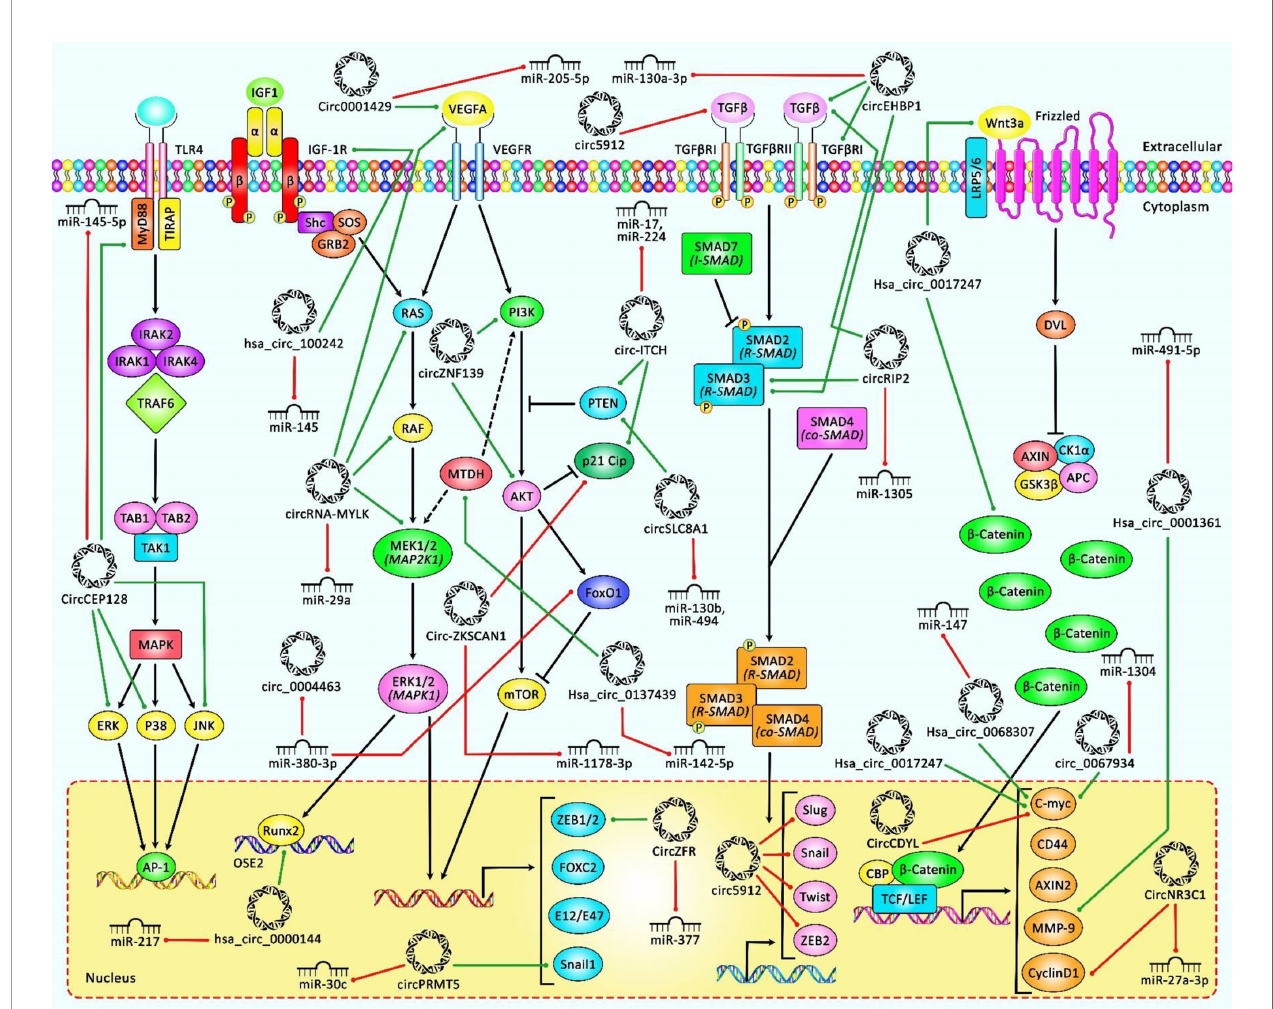
FIGURE 2 | A schematic representation of the role of various circRNAs in human bladder cancer through modulating the PI3K/AKT, MAPK/ERK, TGF b /SMAD3, and Wnt/ b -catenin signaling pathways. According to the diagram, the upregulation or downregulation of several circRNAs could have a considerable role in bladder cancer development through modulation of miRNA levels. Green arrows indicate upregulation of target genes by circRNAs, and red arrows depict inhibition regulated by them. All the information regarding the role of these circRNAs in bladder cancer is shown in Tables 1 , 2